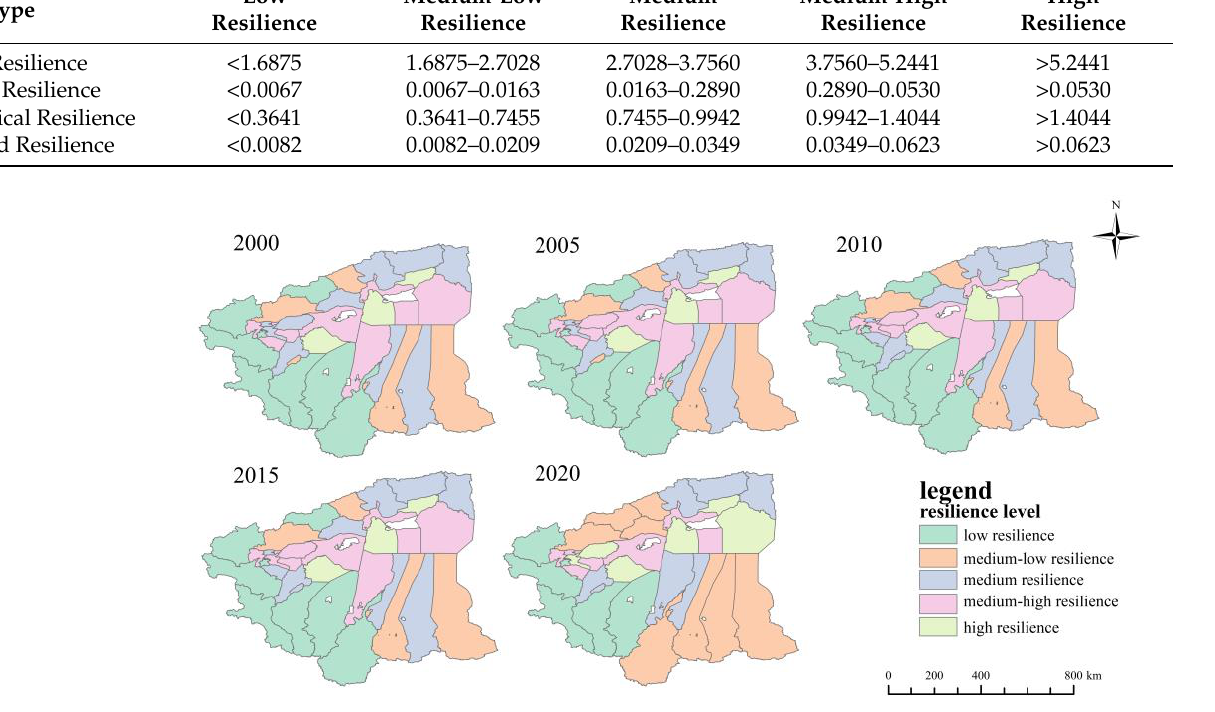
Table 5. Weight of density resilience index determined by different methods.